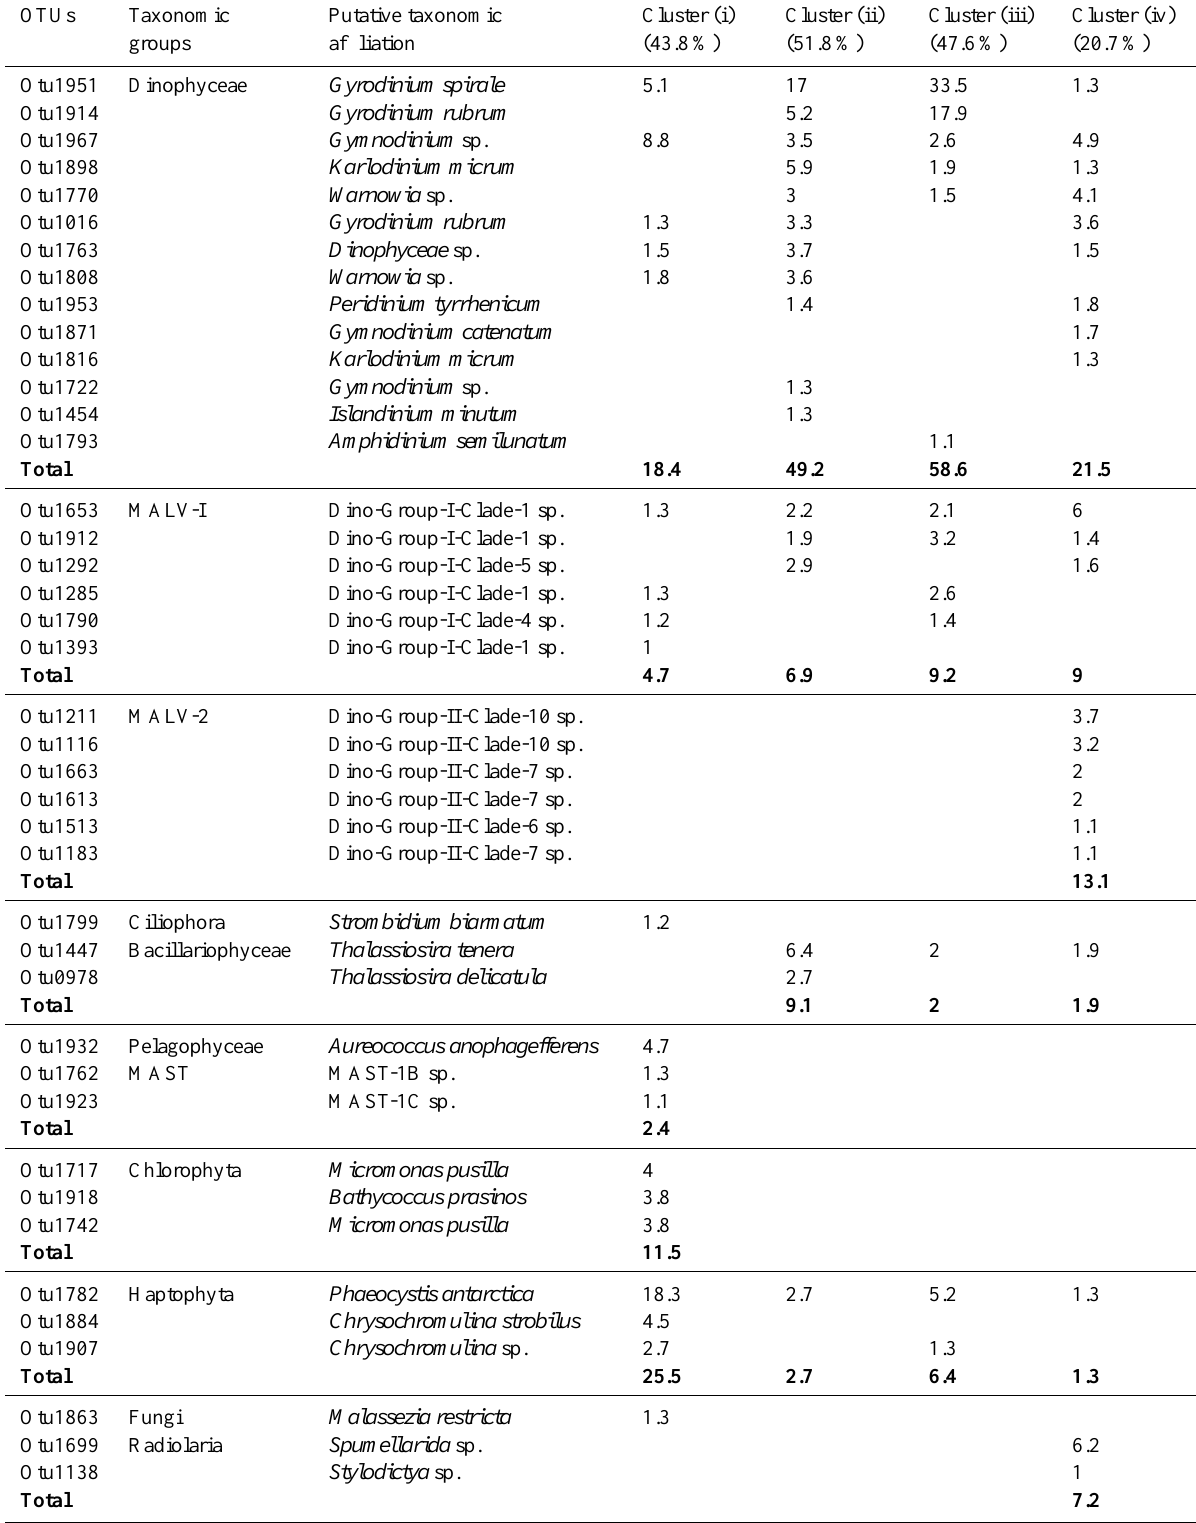
Table 5. Results of SIMPER (similarity percentages) following the Bray–Curtis cluster analysis (Fig. 6a). Forty-one OTUs contributing for at least 1% of the similarity of each cluster are listed in this table. In parentheses, the mean of Bray–Curtis similarity is given for each